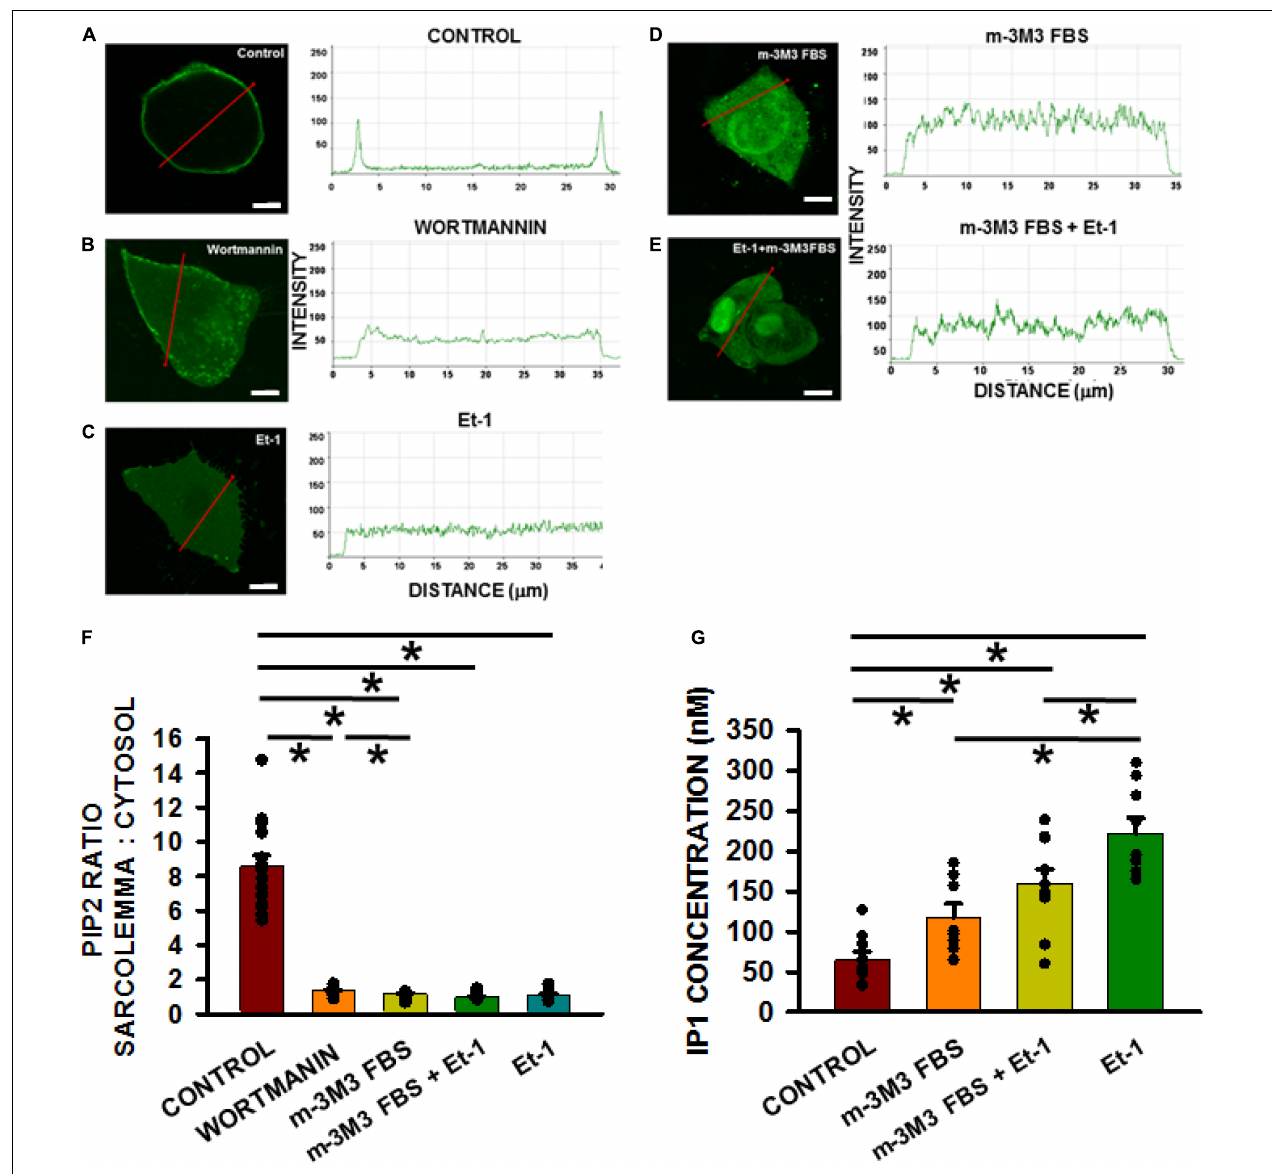
FIGURE 4 | Membrane PIP2 levels decrease significantly in HL-1 cells with active treatments compared to non-treated controls. PIP2 depletion measurements in HL1 cells transfected with the PLC δ 1-PH-GFP construct. Quantification measured as the fluorescence intensity change along the red line from membrane to cytosol ( A–E , scale bar = 5 µ m). Pixel size was 0.11 µ m/pixel and all images were obtained with the pinhole adjusted to Airey units = 1. Bar graph (F) shows results of controls ( n = 15 wells) compared to cells pre-incubated with wortmannin ( n = 13), m-3M3FBS ( n = 12 wells), Et-1 ( n = 12), and combination of Et-1 and m-3M3FBS ( n = 15 wells) from 3 separate cultures each. (G) Measurements of IP1 in different treatment groups. Control n = 9 wells; Et-1 n = 8; m-3M3FBS n = 9; m-3M3FBS+Et-1 n = 10 obtained from 3 cultures each. Statistical comparisons were made using a one-way ANOVA in (F,G) . * p <